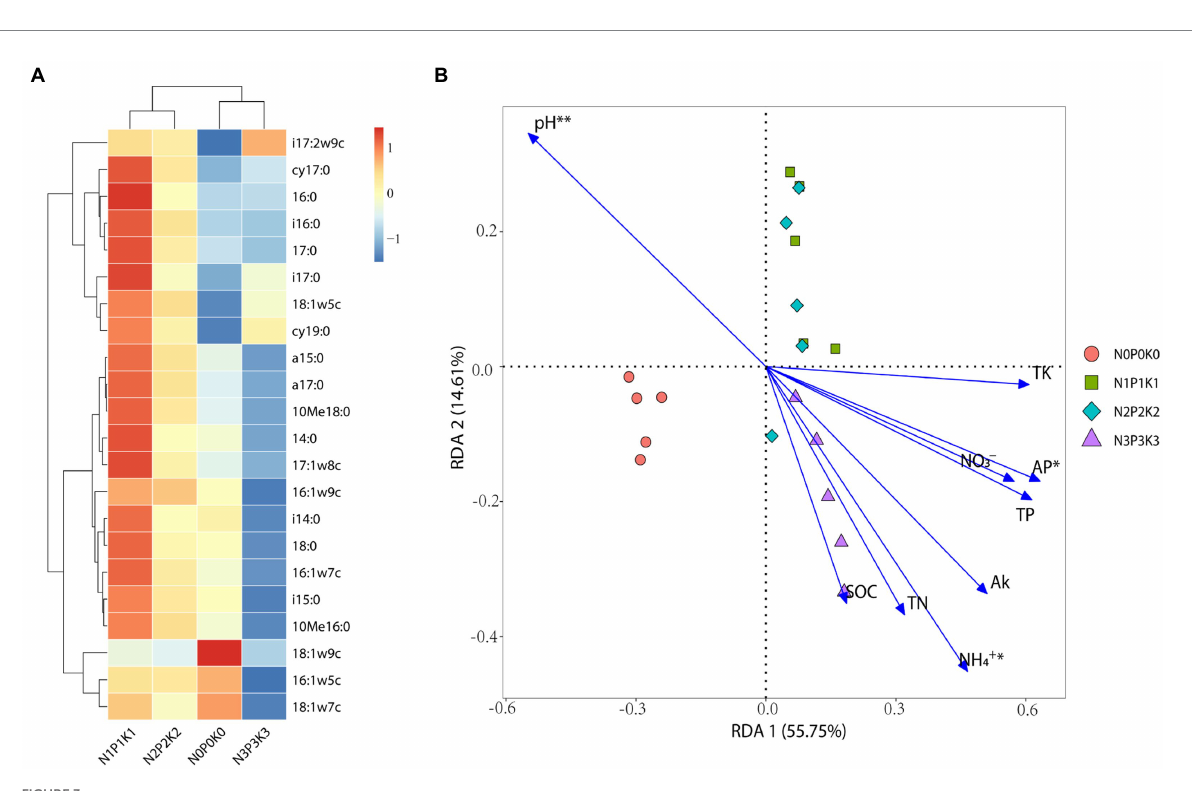
FIGURE 3 The effects of different fertilization levels on soil microbial communities. (A) Heatmap of relative abundance of microbial PLFAs, reddish color indicates increased metabolites content while bluish color indicates decreased metabolites content. (B) Redundancy analysis (RDA) of the rhizosphere microbial PLFAs with soil chemical properties, Significant variables via forward selection are labeled with asterisk (**, and * represent p < 0.01, and 0.05,